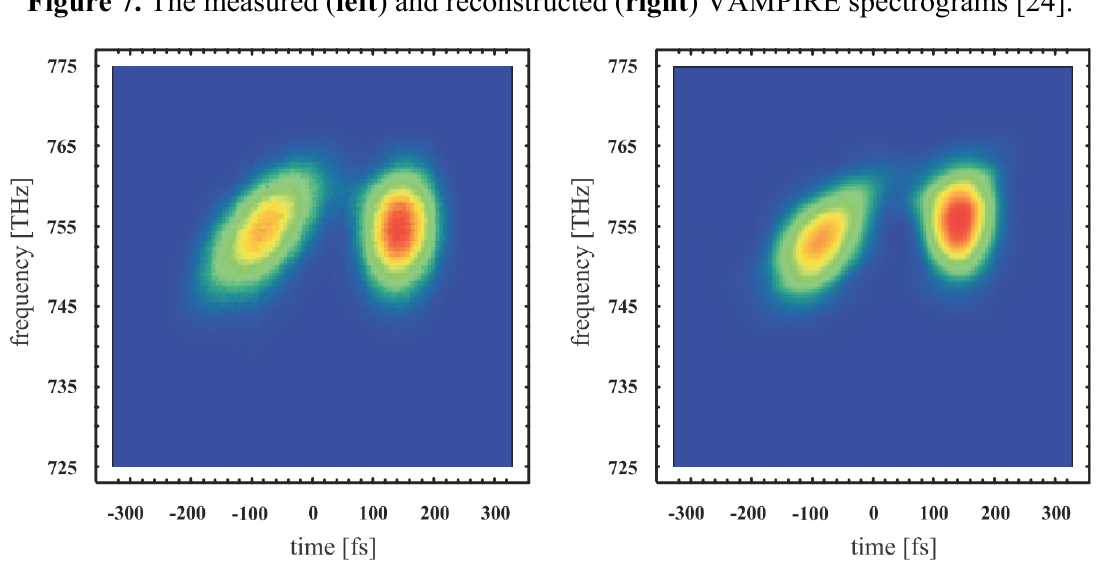
Figure 7. The measured ( left ) and reconstructed ( right ) VAMPIRE spectrograms [24].